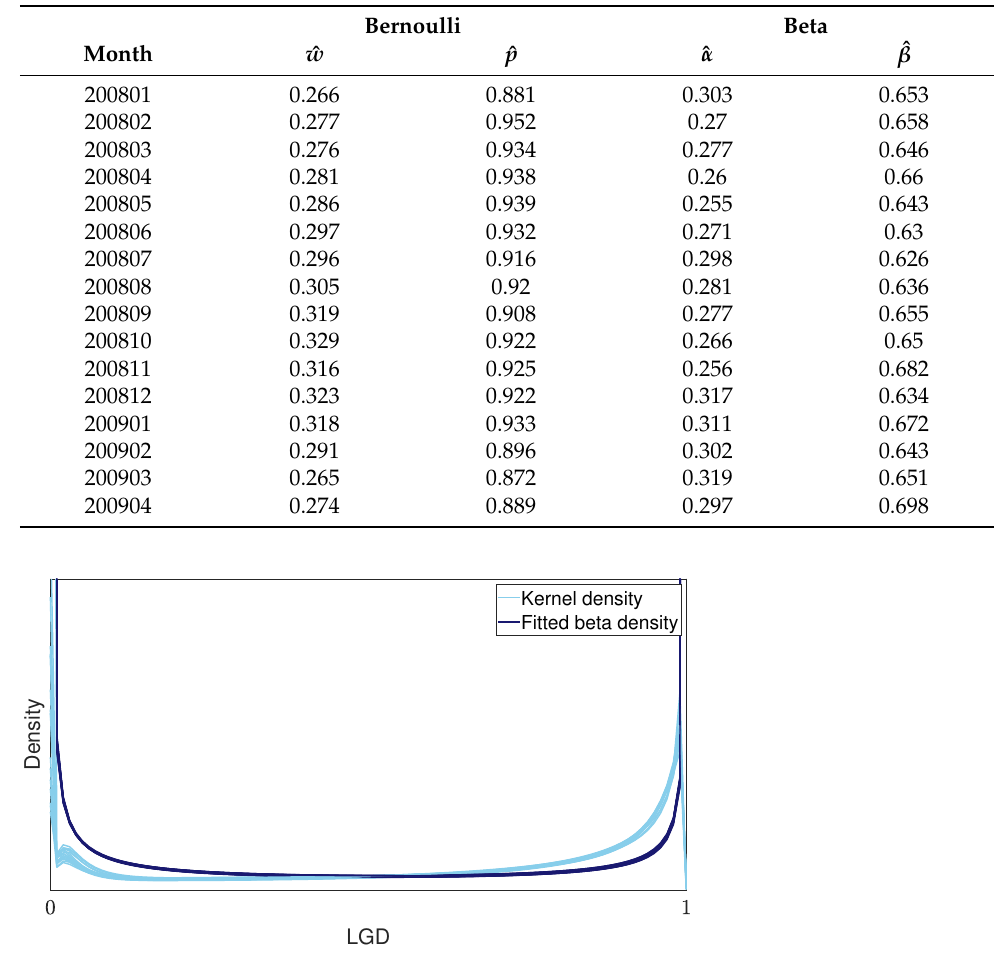
Table 1. Parameter estimates of benchmark model.